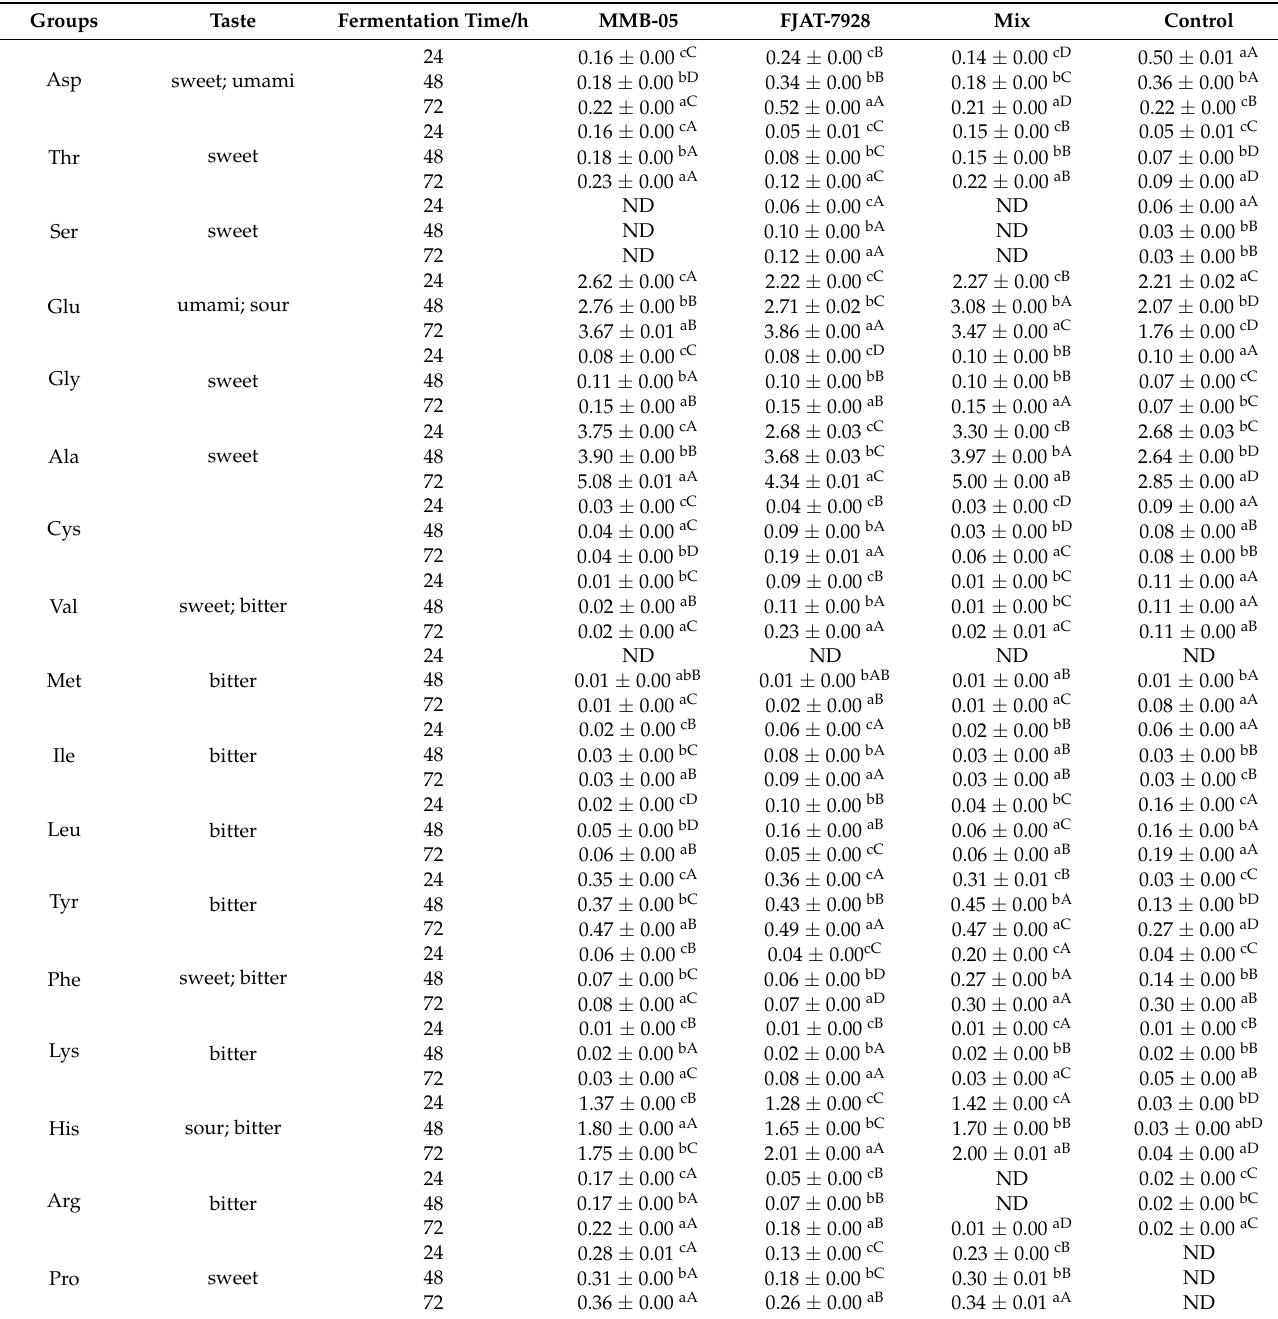
Table 3. Changes of free amino acid contents in P. yezoensis sauces during fermentation